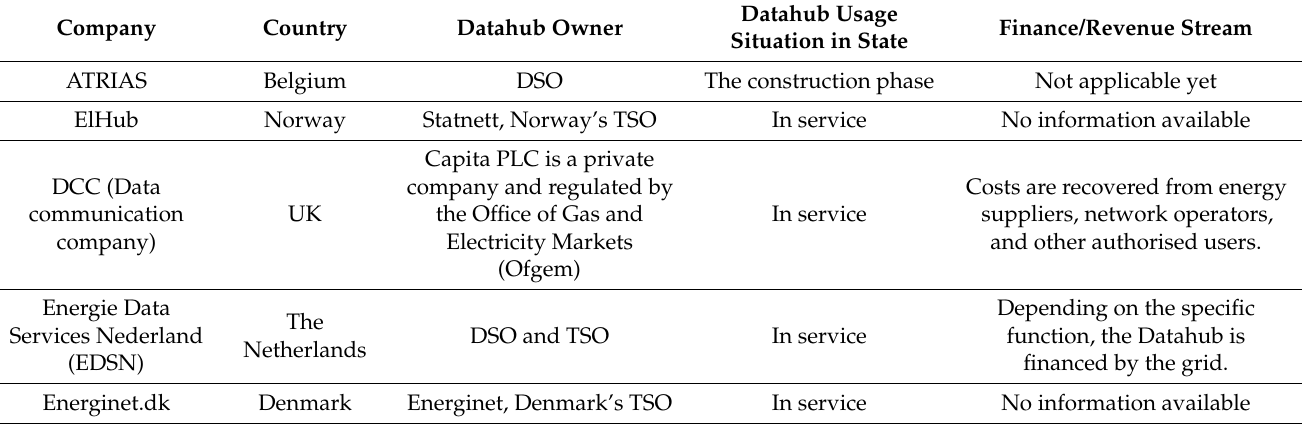
Table 1. Energy Datahubs